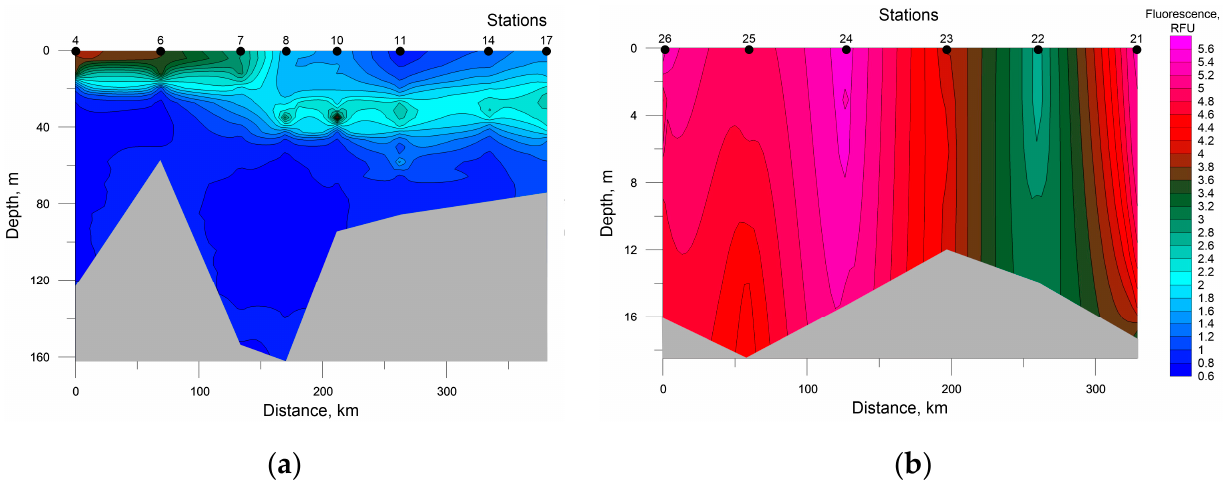
Figure 8. Distribution of seawater fluorescence at the investigated transects in the southwestern Kara Sea ( a ) and the southeastern Barents Sea ( b ).